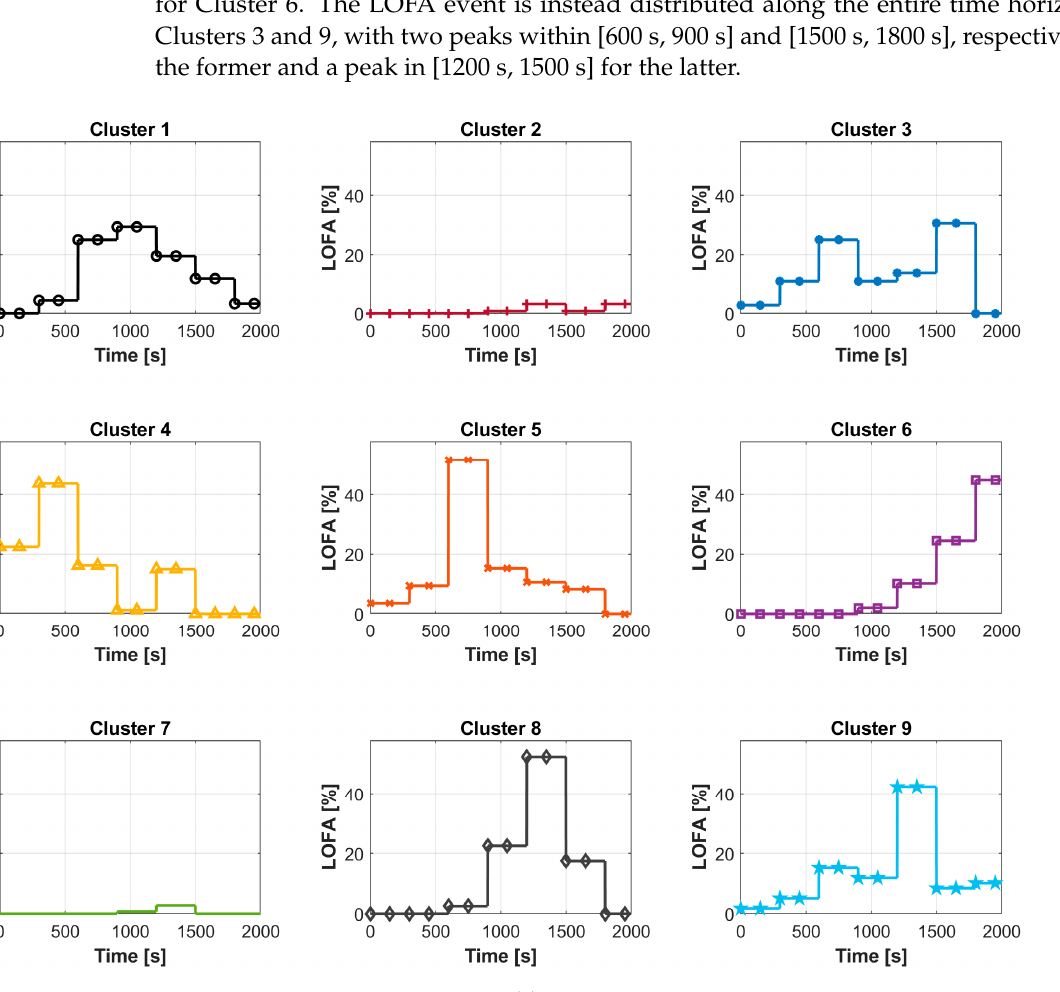
Figure 11. Probability of LOFA occurrence time (cid:1842) (cid:3013)(cid:3016)(cid:3007)(cid:3002),(cid:3039) ((cid:1855)) (Equation (11)) for each cluster c = 1, 2, …, 9. The conditional failure probability (cid:1842) (cid:3007)(cid:3002)(cid:3010)(cid:3013),(cid:3039) ((cid:1857)|(cid:1855)) of each component e for Cluster 4 as a